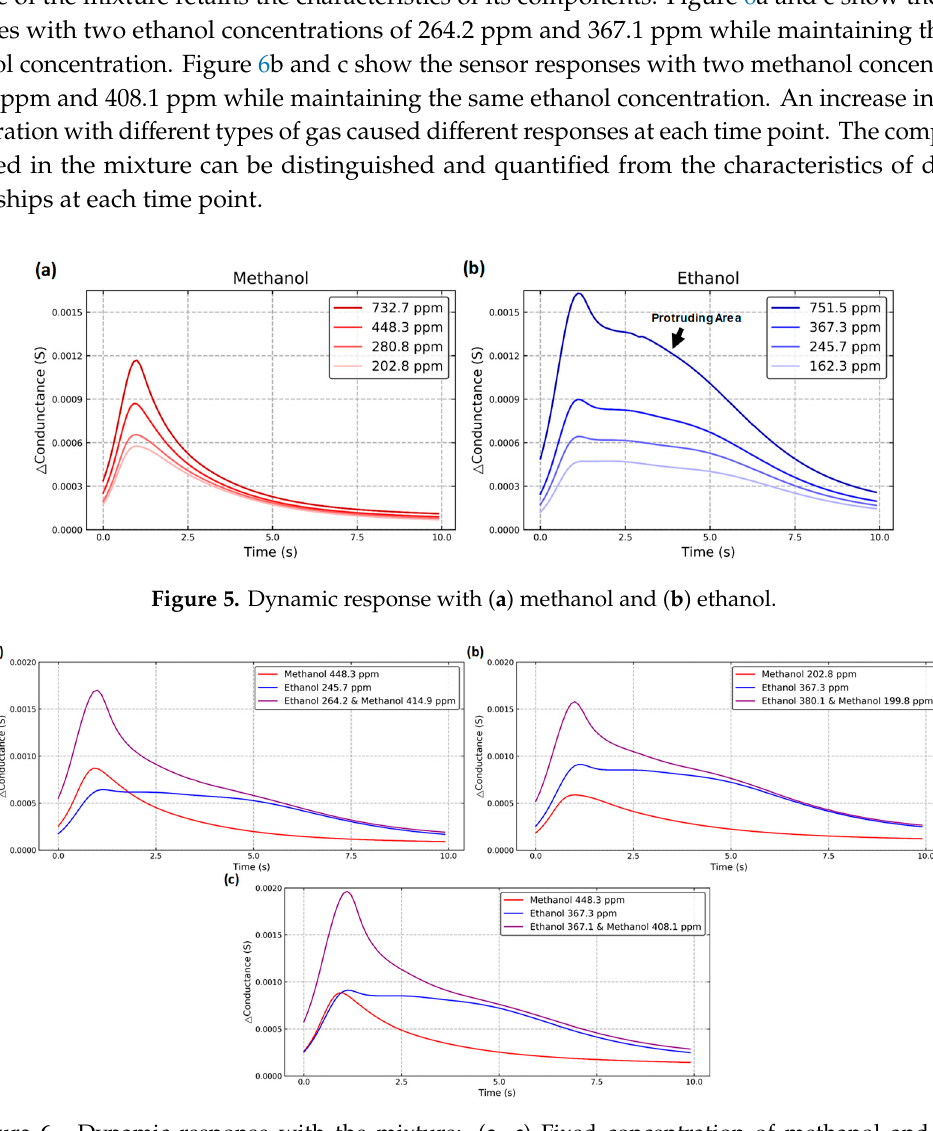
Figure 6. Dynamic response with the mixture: ( a , c ) Fixed concentration of methanol and an increasing concentration of ethanol; ( b , c ) fixed concentration of ethanol and an increasing concentration of methanol.